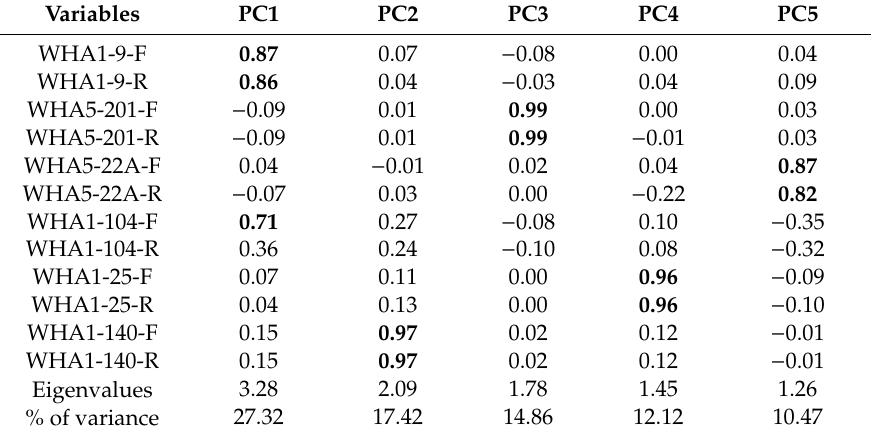
Table 2. Principal components extracted from a principal component analysis to determine clustering of genotyping data for Dryophytes sp. in the Republic of Korea. The variables were based on the genotyping result for 381 individuals and set so that principal components were extracted from all 12 variables (six markers; 2n) if their eigenvalue was > 1 under a varimax rotation. Values with the highest loading factor are highlighted in bold. Please note that WHA1-104-R loads only weakly in any of the principal components